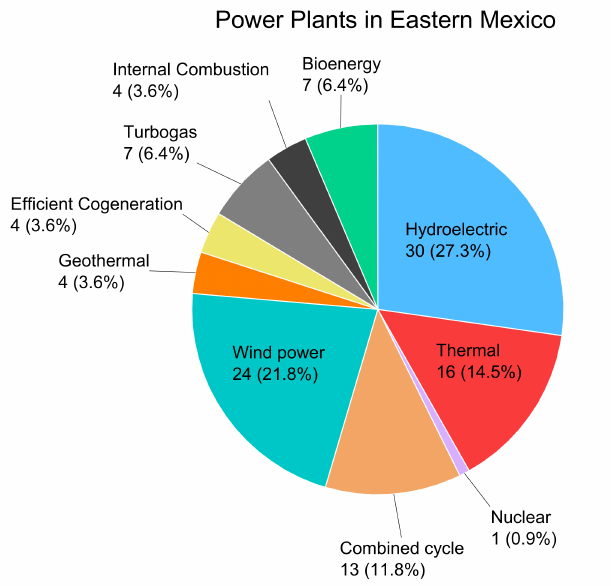
Figure 2. Classification of generation plants in the Eastern Zone of Mexico according to technology used